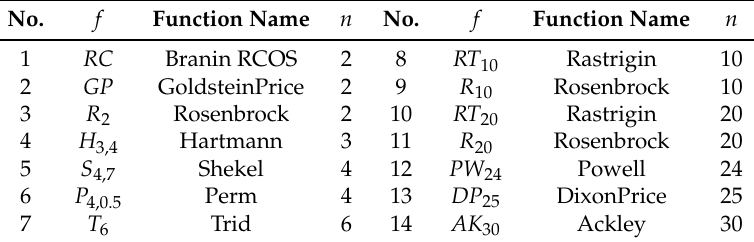
Table 1. Test functions for global optimization: Set A.